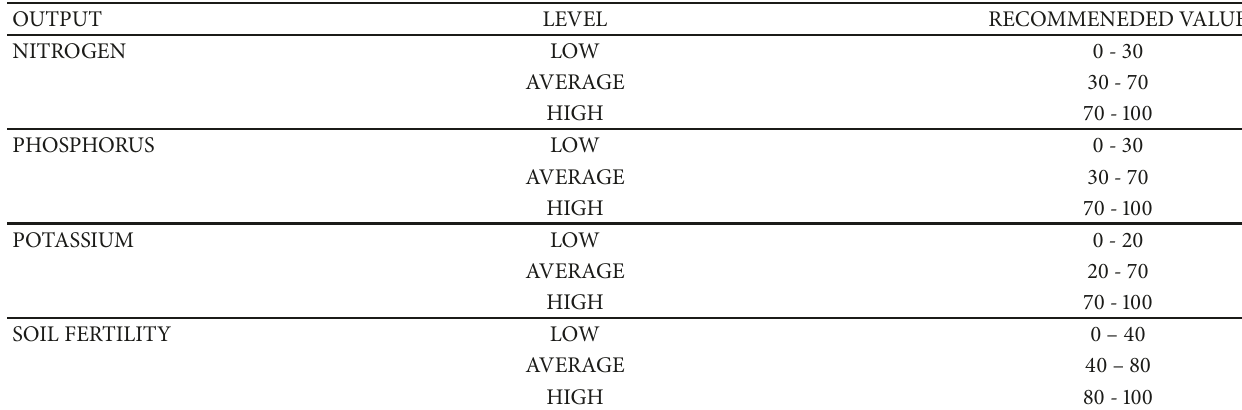
Table 2: Output variables showing linguistic variables and recommended